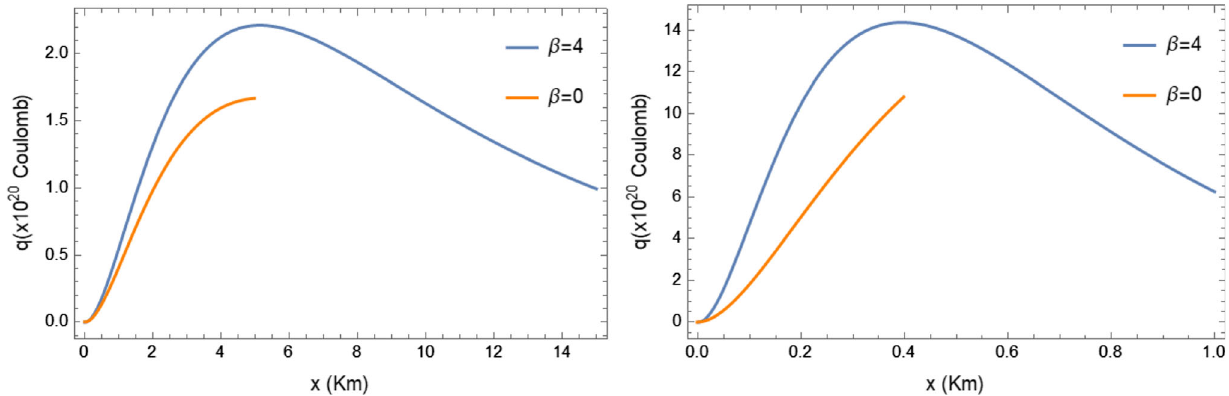
Fig. 3 Variation of the electric charge q as a function of the radial coordinate x inside the stellar interior